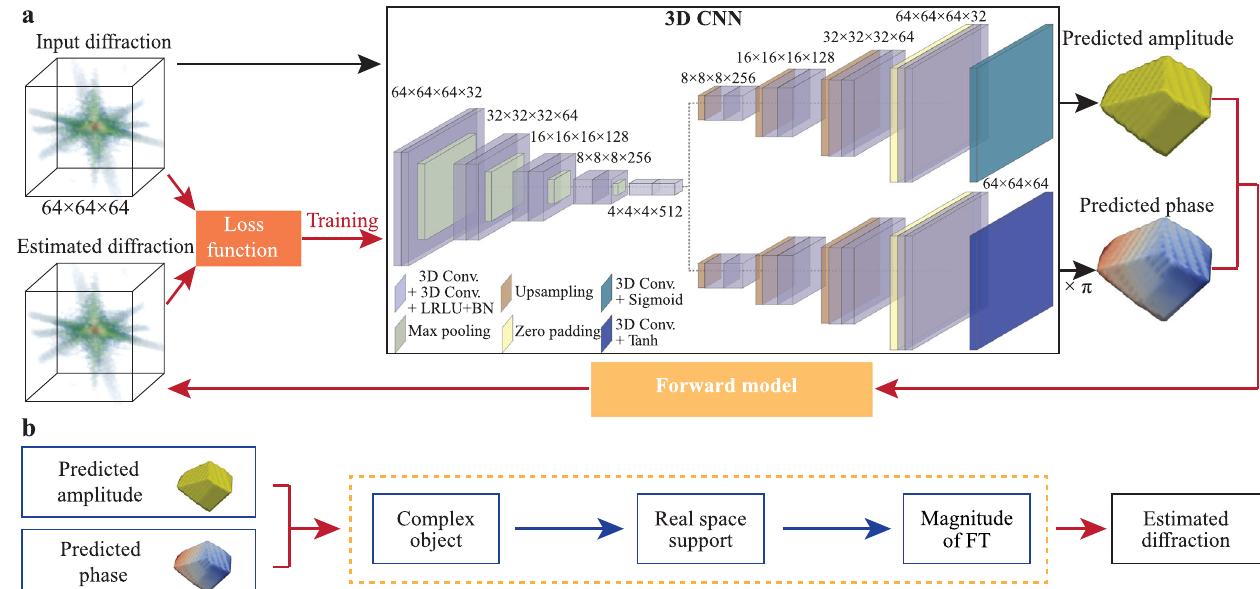
Fig. 1 Schematic of the neural network structure of AutoPhaseNN model during training. a The model consists of a 3D CNN and the X-ray scattering forward model. The 3D CNN is implemented with a convolutional auto-encoder and two deconvolutional decoders using the convolutional, maximum pooling, upsampling and zero padding layers. The physical knowledge is enforced via the Sigmoid and Tanh activation functions in the fi nal layers. b The X-ray scattering forward model includes the numerical modeling of diffraction and the image shape constraints. It takes the amplitude and phase from the 3D CNN output to form the complex image. Then the estimated diffraction pattern is obtained from the FT of the current estimation of the real space